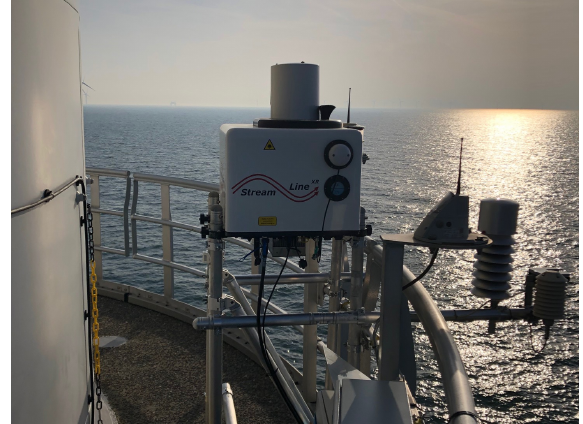
Figure 2. Long-range-scanning lidar and additional measurement systems (on the right side) on the TP of one of the northernmost wind turbines (K01) at the wind farm Gode Wind 1.